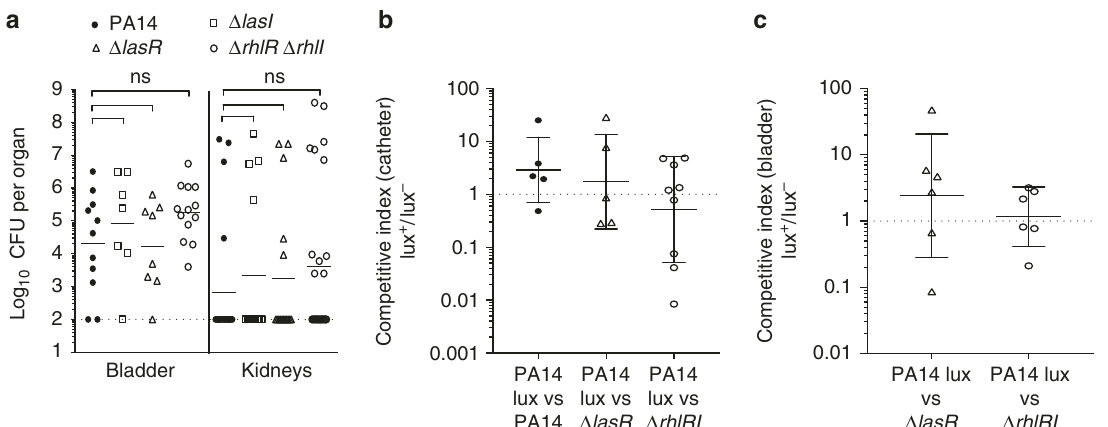
Fig. 4 Quorum sensing is not required for catheter-associated urinary tract infection. a Bacterial load of the bladders and kidneys from mice infected with either PA14, Δ lasR , Δ lasI , or Δ rhlRI using the CAUTI model of infection. The dashed line represents the limit of detection. Competitive indices (CI) for b bio fi lm formation in the catheter and c establishing infection in the bladder when mice were co-infected with PA14-lux and either unmarked PA14, Δ lasR , or Δ rhlRI in CAUTI. CI were calculated by fi rst determining the ratio of lux + and lux − CFU recovered from the catheter or infected bladder and then dividing by the ratio of lux + and lux − CFU of the inoculum used for infection. Each symbol represents the CI measured for an individual bladder or a catheter. Dashed lines represent a CI value of 1 where no competition is observed. Horizontal line represents the geometric mean and error bars represent standard